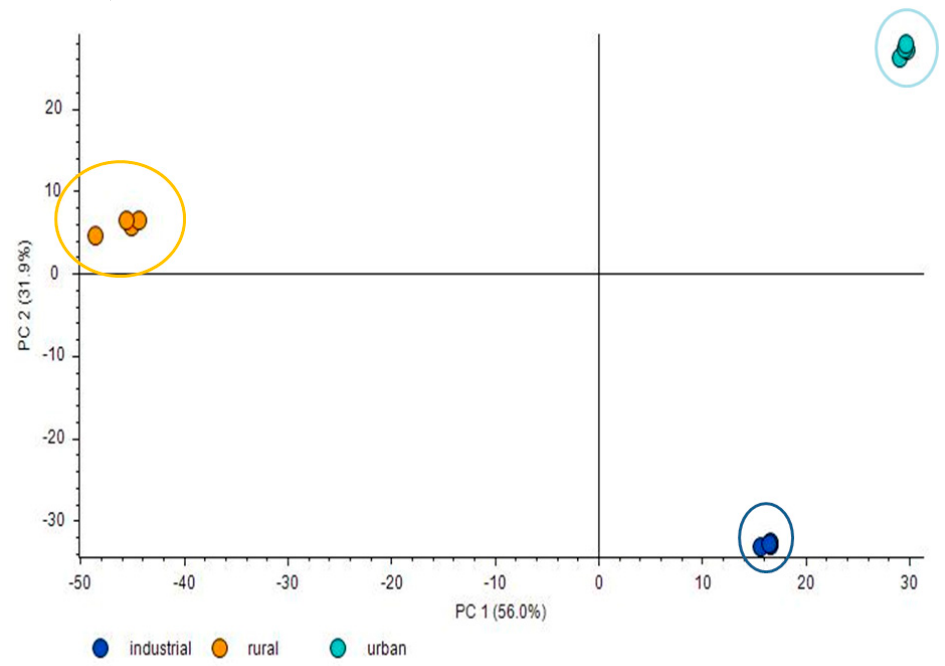
Figure 2. Two dimensional PCA score plot of air samples for industrial, rural and urban areas.